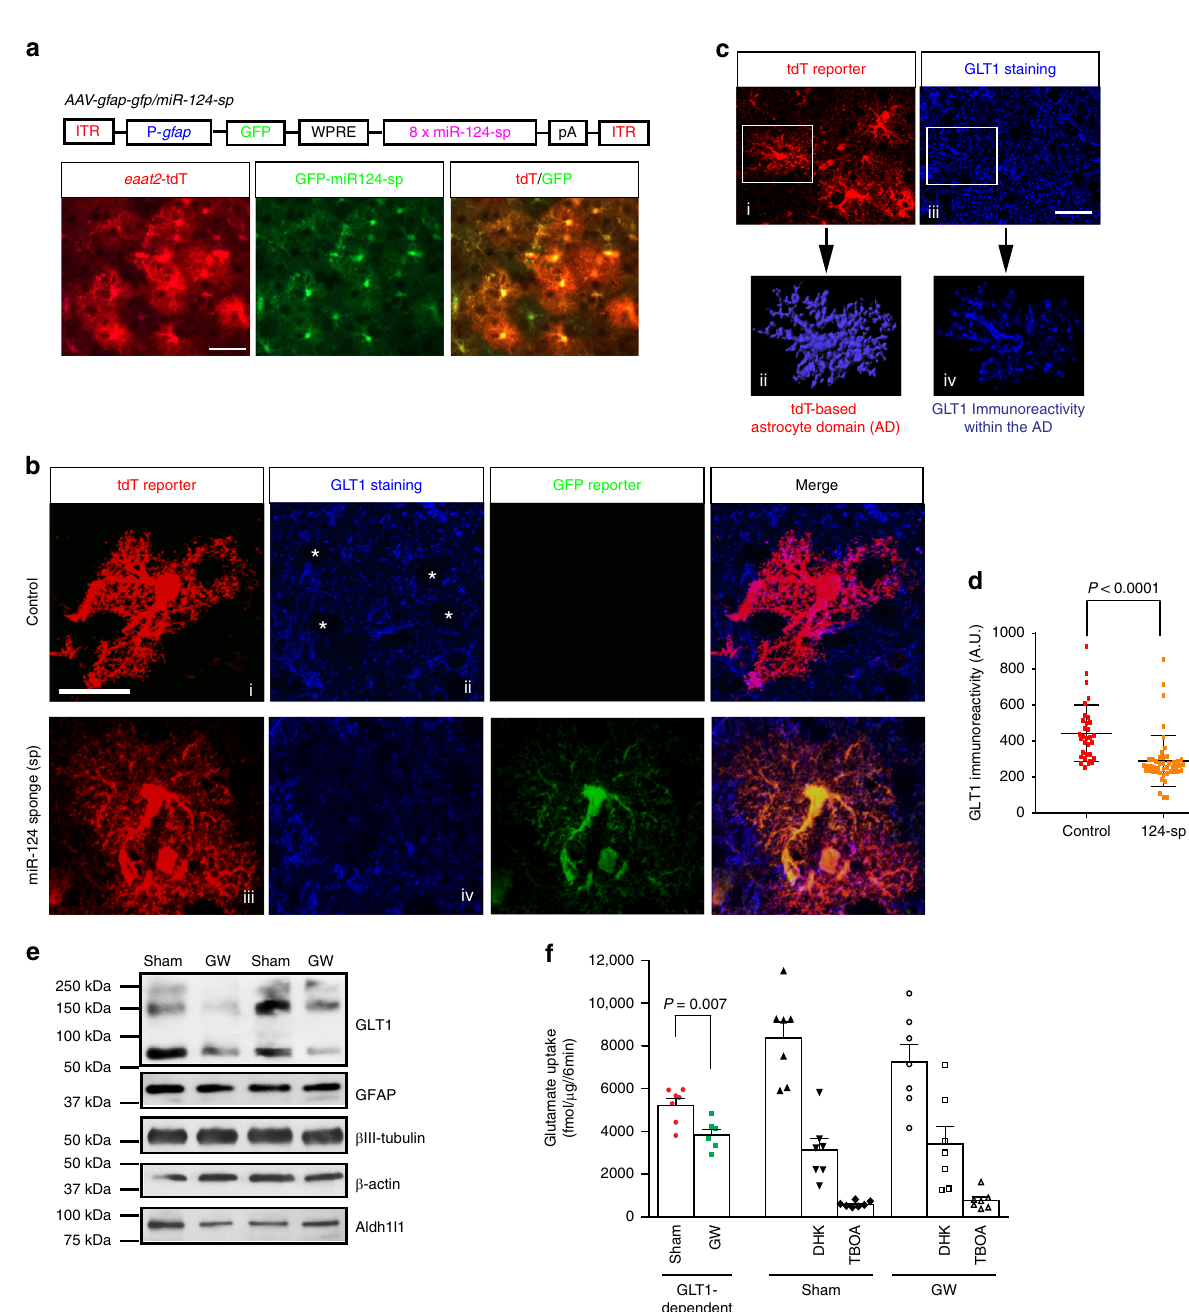
Fig. 7 Selective inhibition of astroglial miR-124-3p and exosome secretion in vivo reduces functional GLT1 expression. a Diagram of AAV- gfap -GFP/miR- 124-sponge (GFP-miR-124-sp) viral construct, and representative images of GFP-miR-124-sp expression in cortical tdT + astrocytes of eaat2 -tdT astrocyte reporter mice in vivo. Scale bar: 50 μ m; b Representative images of cortical astrocytes from control and GFP-miR-124-sp injected eeat2 -tdT astrocyte reporter mice. Subpanels i and iii: tdT + astrocytes; ii and iv: GLT1 staining on astrocytes in (i) and (iii), respectively; Control: Adjacent non- transduced tdT + astrocytes from AAV injected mice. White asterisks: neuronal somas. Scale bar: 10 μ m; c Representative confocal and 3D images of cortical tdT + astrocytes with GLT1 immunostaining. The astrocyte 3D domain (AD) was generated using Imaris software and then overlapped with GLT1 immunoreactivity. Subpanels i: tdT + astrocytes; ii: magni fi ed tdT + astrocyte in (i) after 3D conversion; iii: GLT1 immunostaining; iv: GLT1 immunostaining signals inside the astrocyte domain in (ii); Only GLT1 immunoreactivity within the AD was quanti fi ed. Scale bar: 40 μ m; d Quanti fi cation of GLT1 immunoreactivity within astrocyte domains after miR-124 sponge expression. n = 35 – 45 cells/group/4 mice; P- value was determined using two-tailed unpaired t -test; e Representative GLT1 immunoblot from the cortex of sham- and GW4869-injected mice (daily i.p., from P7 to P35). f Glutamate uptake levels from mouse cortex following sham or GW4869 injections. GLT1-dependent glutamate uptake was calculated by subtracting the remaining glutamate uptake with DHK treatment from total glutamate uptake. n = 7 mice/group; P -values were determined using two-tailed unpaired t -test. Error bars were presented in